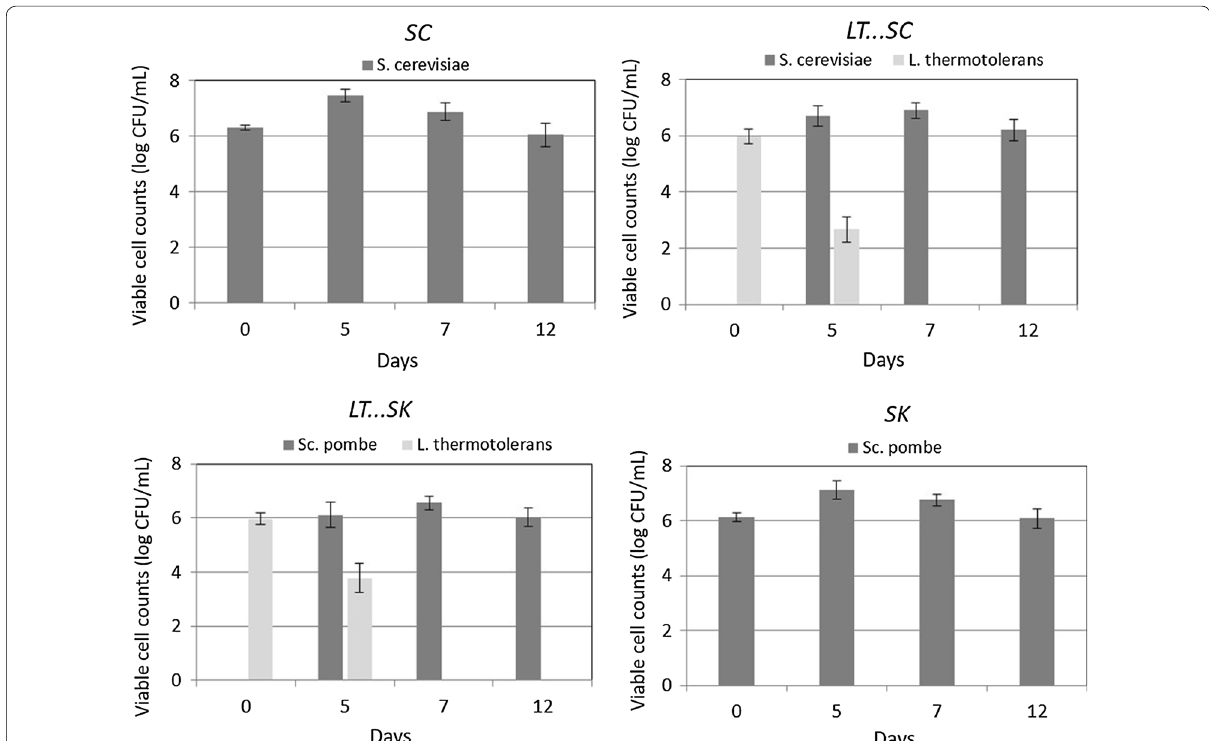
Fig. 1 Change in the population of S. cerevisiae 87 alone (SC), sequential fermentation with Saccharomyces cerevisiae 87 and L. thermotolerans CONCERTO ™ (LT…SC), sequential fermentation with S. pombe V2 and Lachancea thermotolerans CONCERTO ™ (LT…SK) and S. pombe V2 alone (SK). Values are means standard (logCFU/mL) deviations for three independent fermentations ±